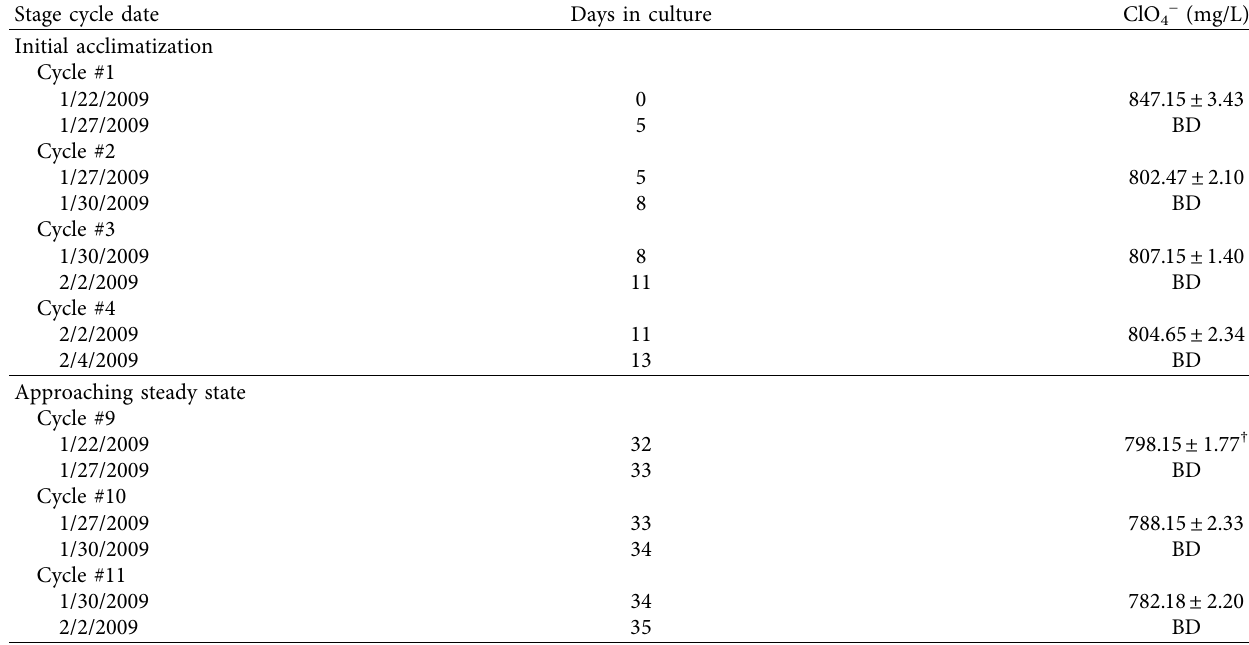
BD, below detection; EMC, enriched microbial biomass.